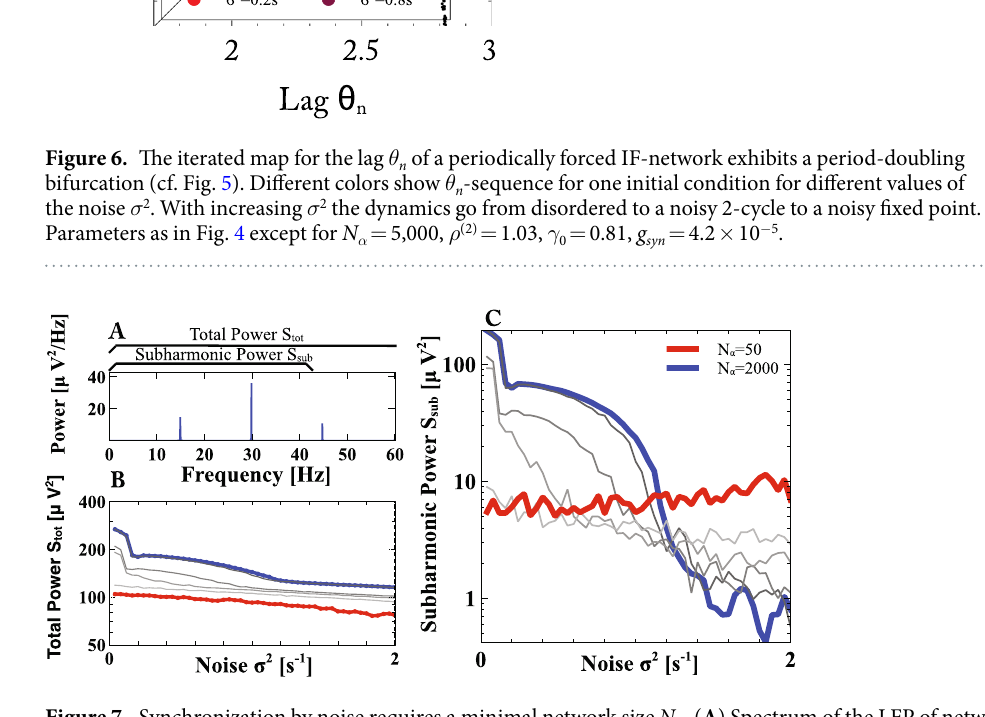
Figure 7. Synchronization by noise requires a minimal network size N α . ( A ) Spectrum of the LFP of network 2 indicating the frequency range included in the total power S tot and the subharmonic power S sub . ( B ) S tot depends only moderately on noise strength and network size (network sizes as given in the legends of panel (C)). ( C ) Only for sufficiently large networks the subhamornic spectral power S sub decreases strongly with increasing noise strength indicating synchronization (note the logarithmic scale). Network sizes N α : 50 (red), 100, 200, 500, 1,000, 2,000 (blue). Other parameters as in Fig.